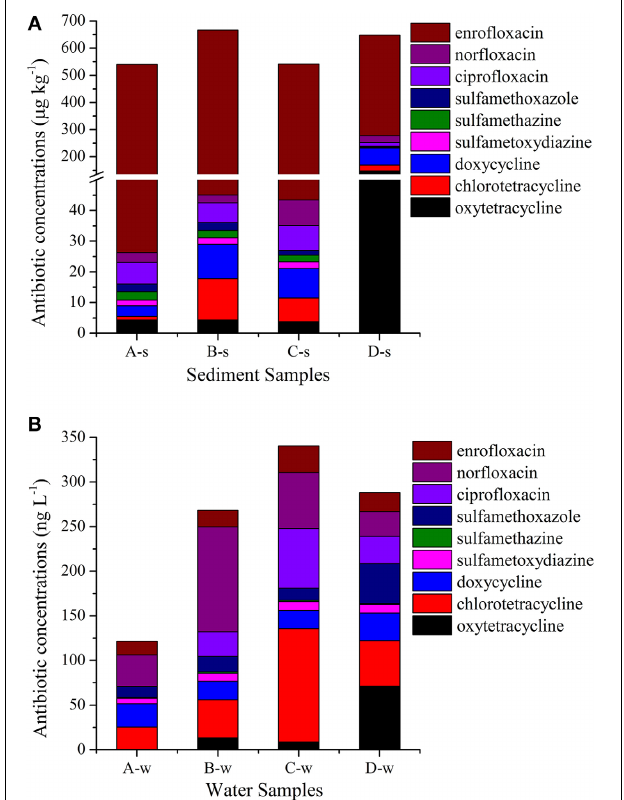
FIGURE 2 | Antibiotic concentrations in sediment samples (A) and in water samples